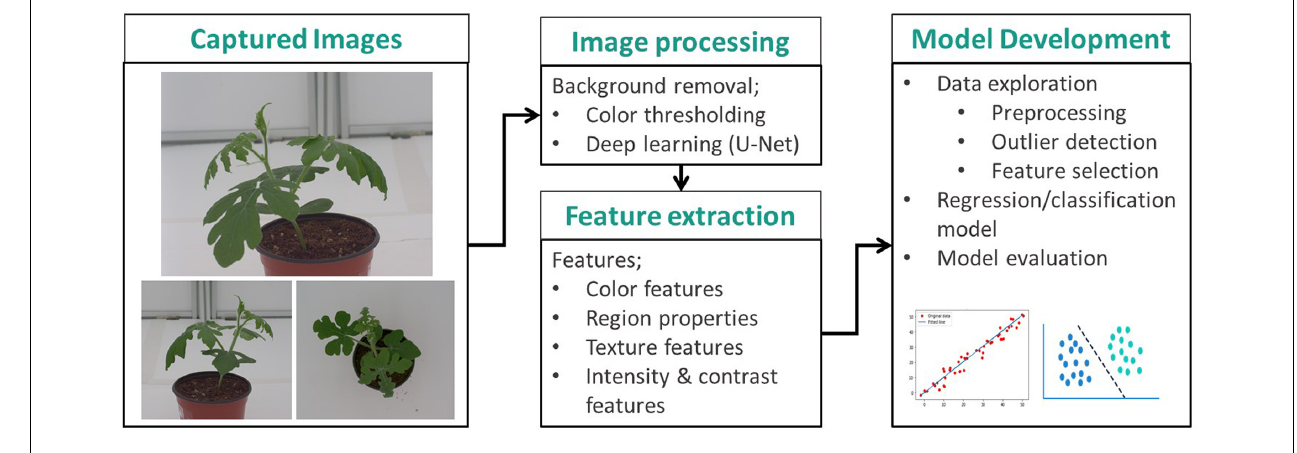
FIGURE 2 | Data analysis workflow.